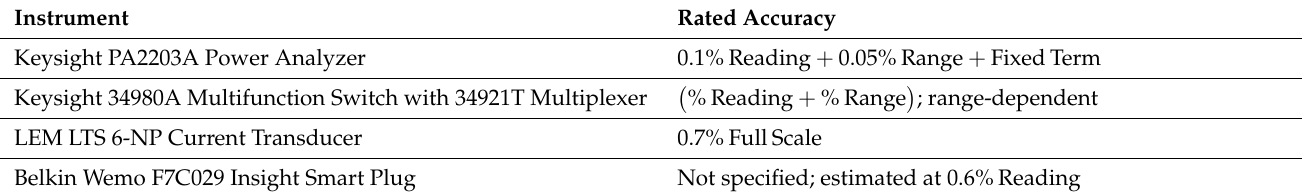
Table A1. Instrument accuracy